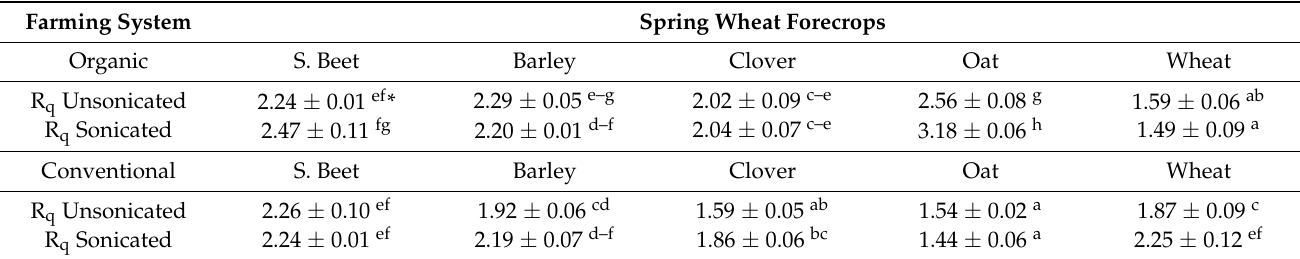
Table 9. Hardness (N) of gluten samples.